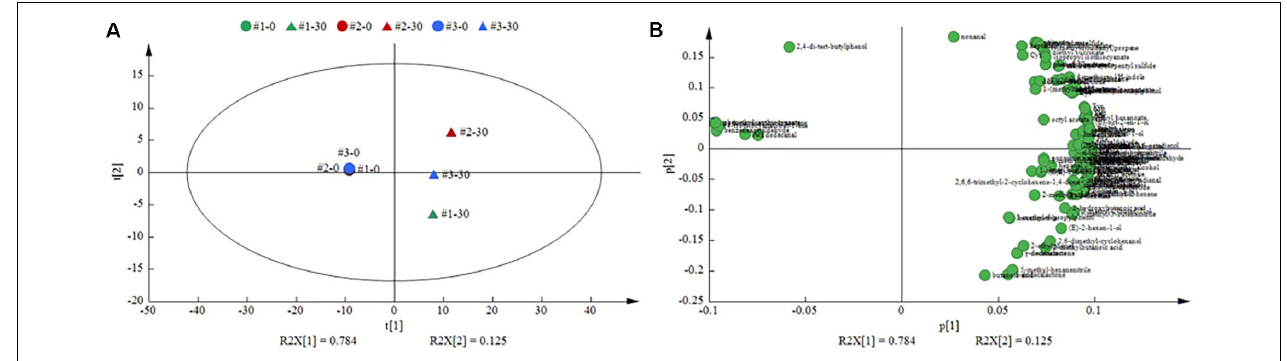
FIGURE 6 | Principal component analysis (PCA) of the volatile metabolites in the traditional northeast sauerkraut from different households. (A) Score plot investigated the differences in volatile metabolites among different homemade sauerkraut samples. (B) Loading plot identified the volatile metabolites responsible for the separation in score plot. #1, #2, and #3 represented three different households. The number behind “ − ” (0, 30) represented fermentation time (day).